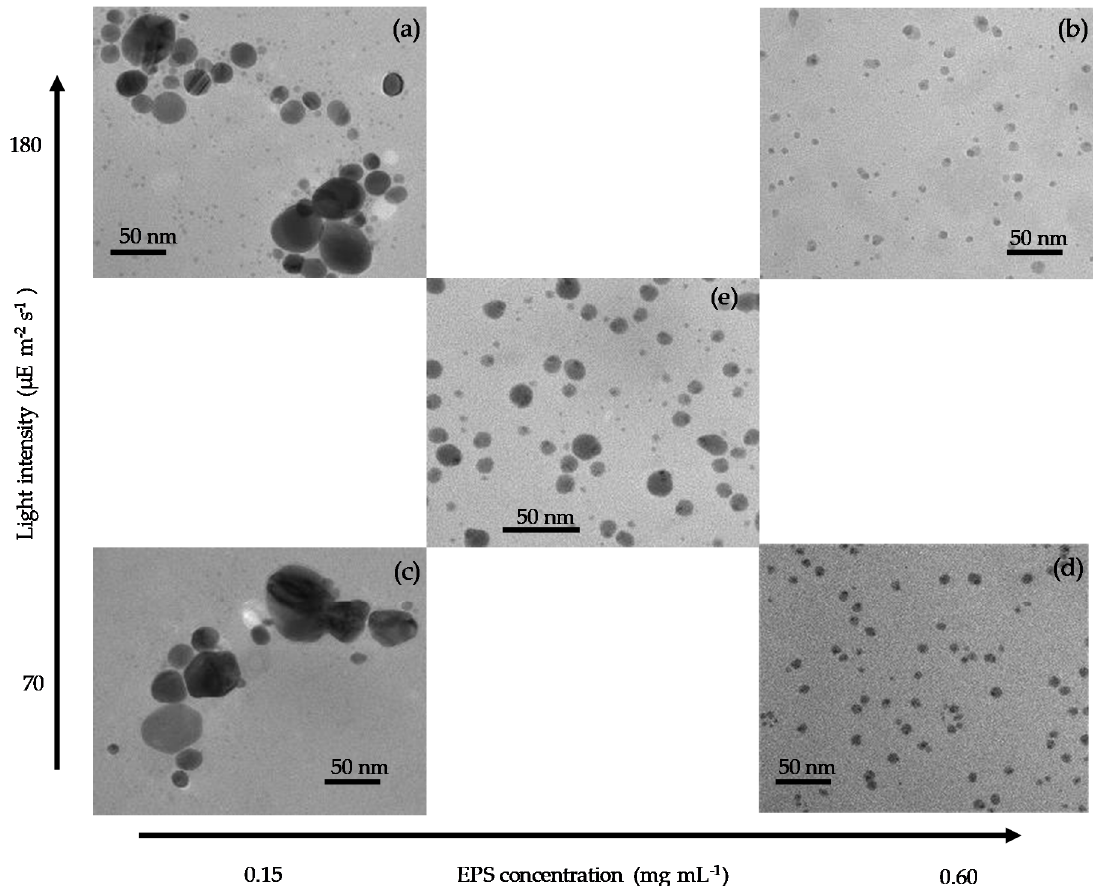
Figure 8. Transmission electron microscope (TEM) micrographs of AgNP samples: ( a ) EPS-0.15-1 mM-180 µ E;( b )EPS-0.60-1mM-180 µ E;( c )EPS-0.15-1mM-70 µ E;( d )EPS-0.60-1mM-70 µ E;( e )EPS-0.38-1 mM-125 µ E.